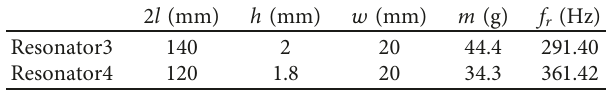
Figure 12: (a) The velocity response of the finite beam with different periods of units. (b) Effects of the period number of units on the average vibration attenuation within the bandgap. Table 3: Parameters and resonance frequency of beam-like